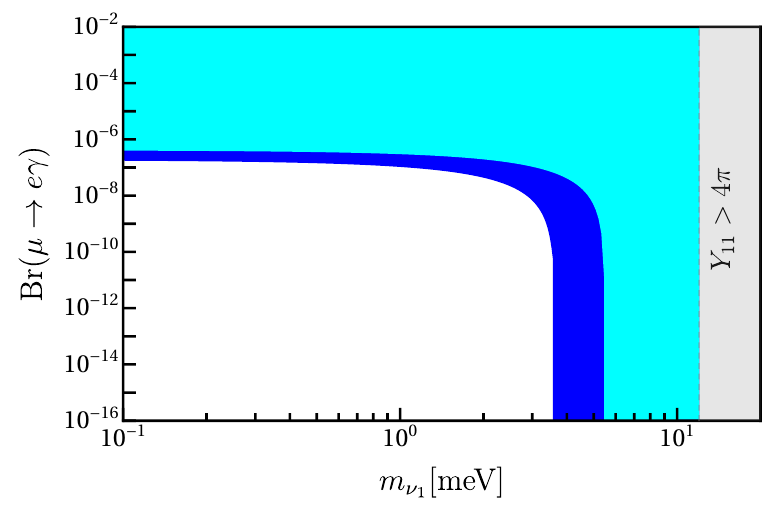
Figure 13 . Br( (cid:22) e(cid:13) ) scanned over neutrino oscillation data in 1 (cid:27) (light blue) and 3 (cid:27) (dark ! blue) ranges. This plot scans over the Majorana phases. The shaded gray area corresponds to the most conservative limit to non-perturbative